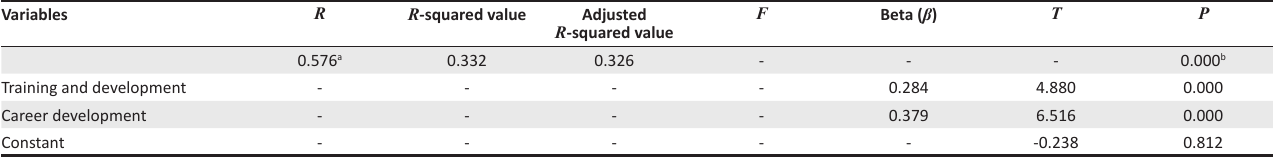
TABLE 5: Multiple